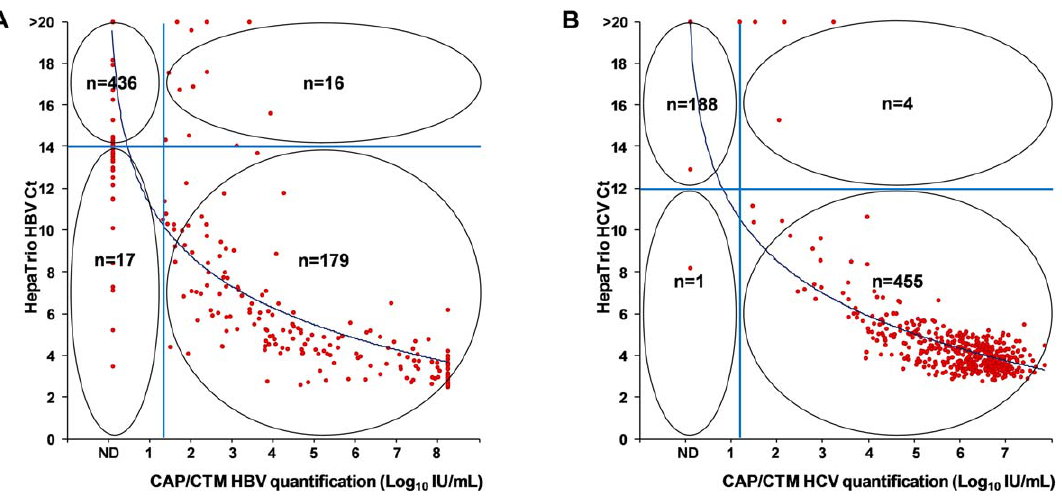
Figure 2. Correlation between cycle threshold (Ct) values on the HepaTrio test and viral concentrations. A. Serum levels of HBV DNA, which were quantified by the Cobas H AmpliPrep/Cobas H TaqMan H (CAP/CTM) HBV assay, correlated well with Ct values on the HepaTrio test (n=648, r = 2 0.9230, 95% confidence interval [CI]= 2 0.9336 to 2 0.9107, P , 0.0001). B. The correlation coefficient between Ct values on the HepaTrio test and serum HCV RNA concentrations measured by the CAP/CTM HCV assay was 2 0.8458 (n=648, 95% CI= 2 0.8663 to 2 0.8223, P , 0.0001). Filled red circles represent individual values and straight blue lines denote cutoff Ct values of the HepaTrio or lower detection limits of the CAP/CTM assays. ND, not detected.